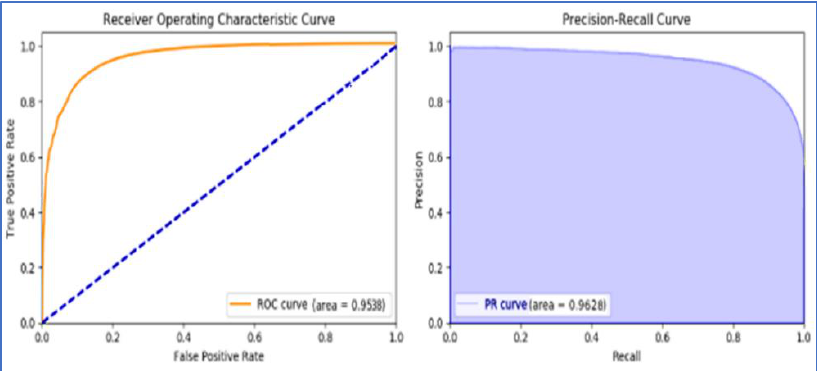
Figure 14. Random Forest Classifiers ROC.